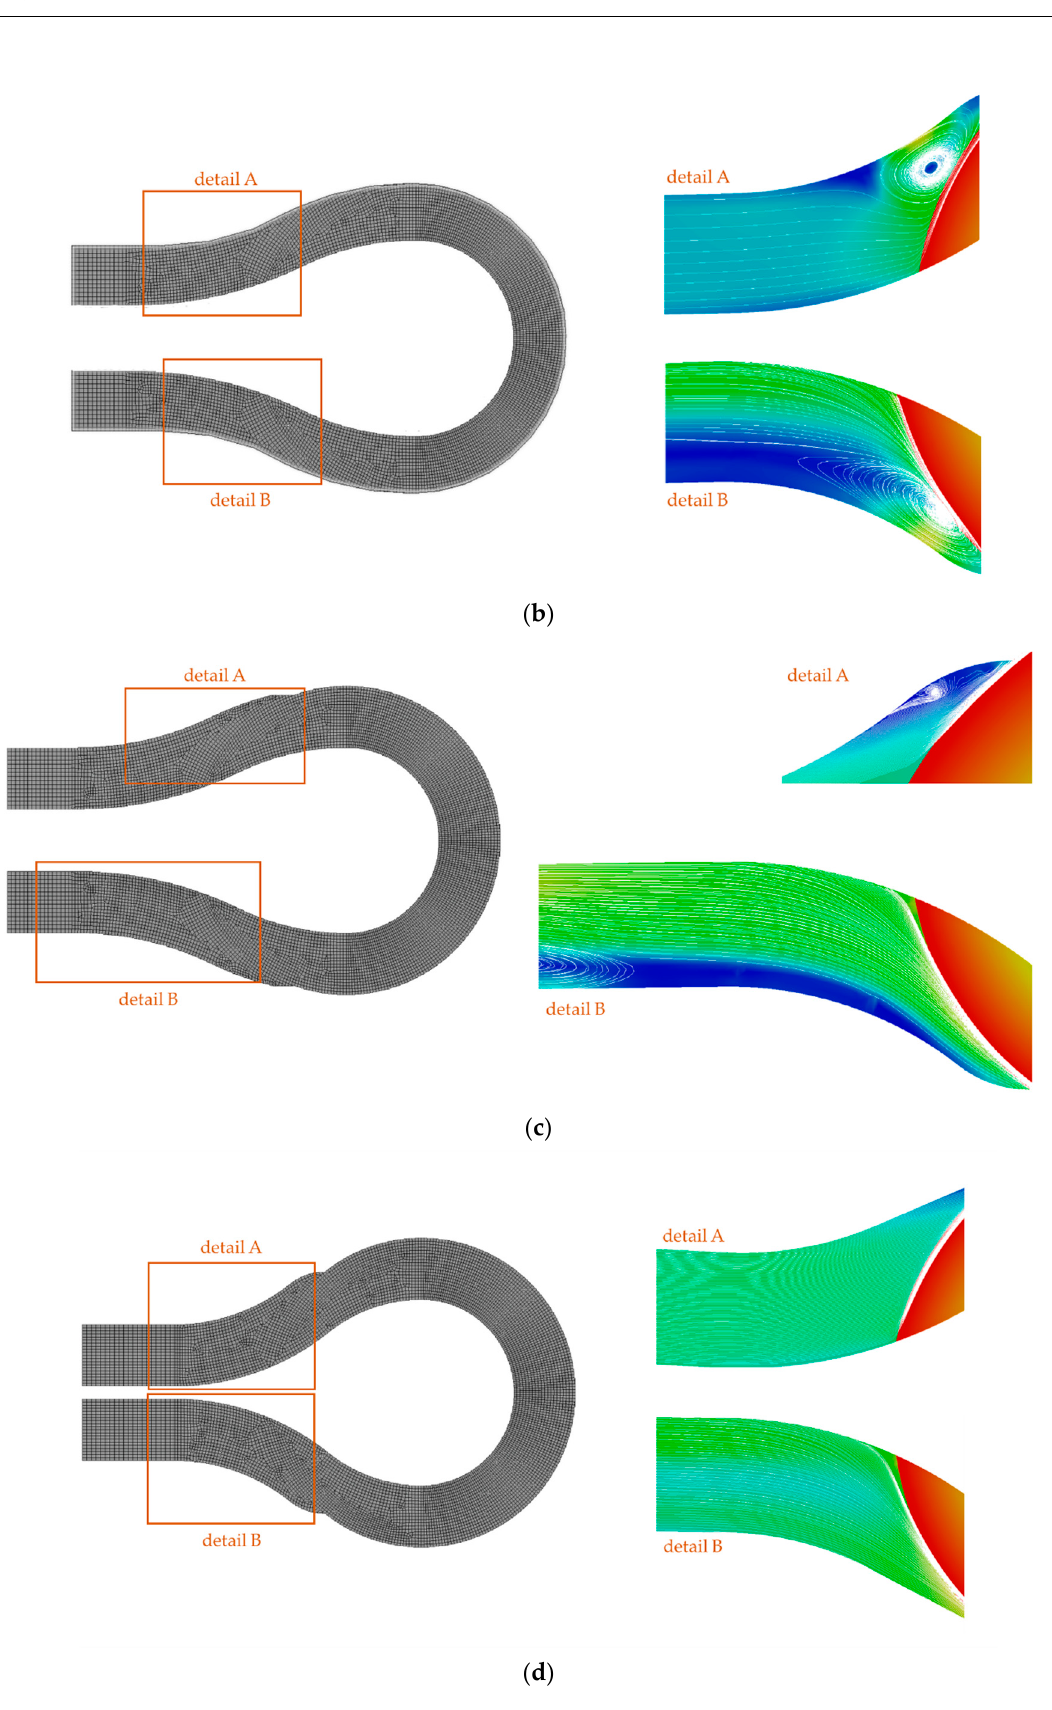
Figure 3. The geometric design iterations with streamlines: ( a ) basic design; ( b ) first improvement of the basic design, ( c ) second improvement of the basic design, and ( d ) third improvement of the basic design.